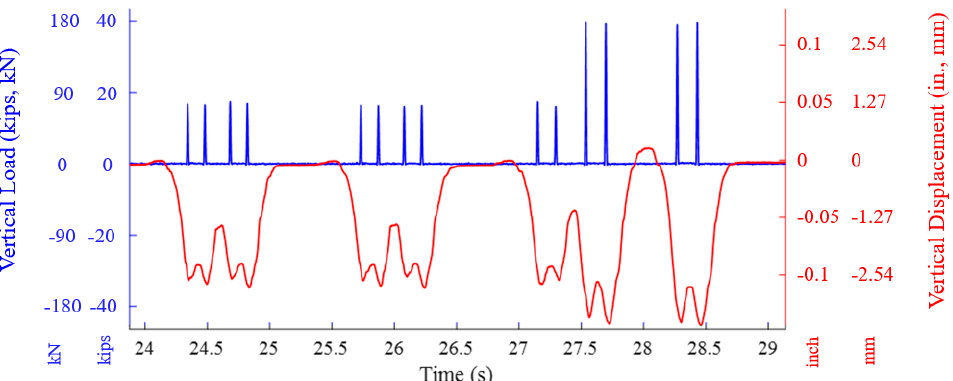
Figure 8. An example of track displacement and wheel load data.